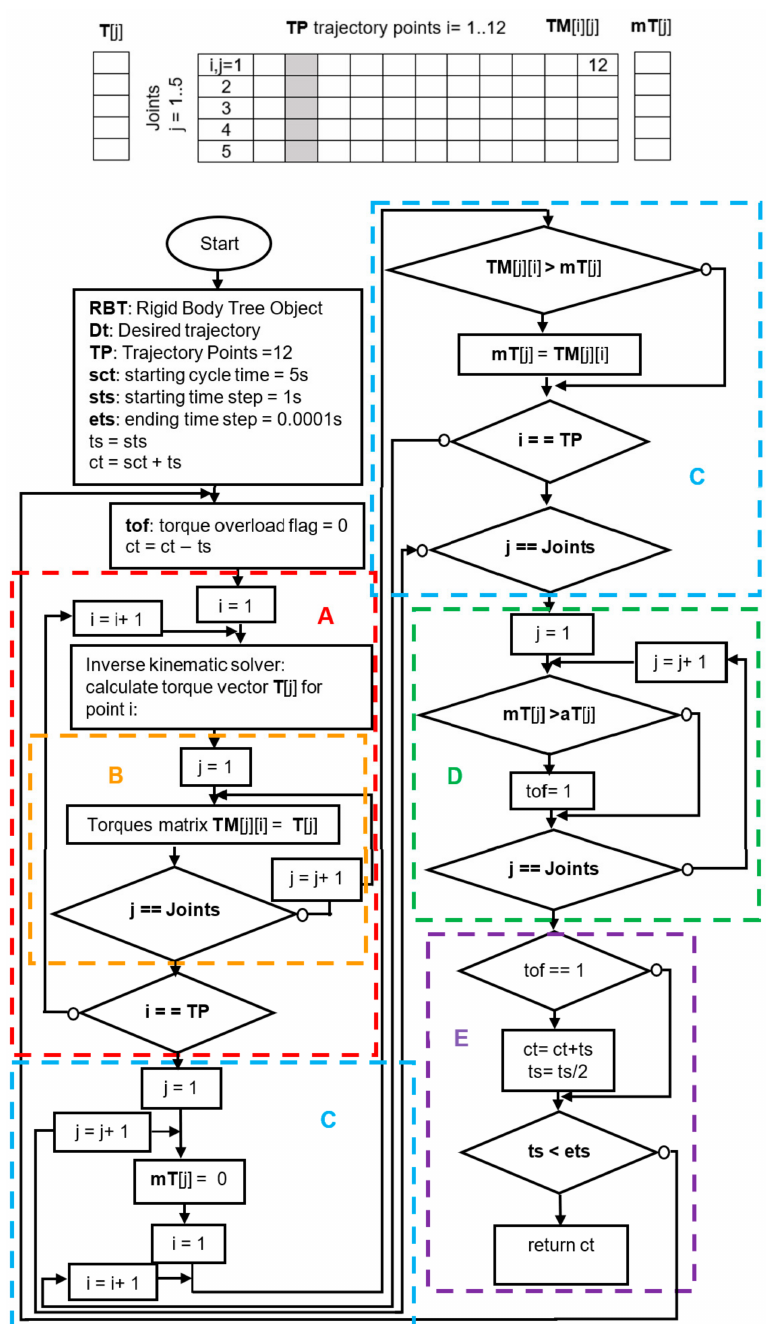
Figure 8. Cycletimeminimizationalgorithm. A–Estandfordifferentblocsthatdefinedifferentcalculations. By running the algorithm for the original and improved trajectories, the two minimum cycle times were determined and compared. In Figure 8, the elaborated cycle time minimization algorithm is introduced in